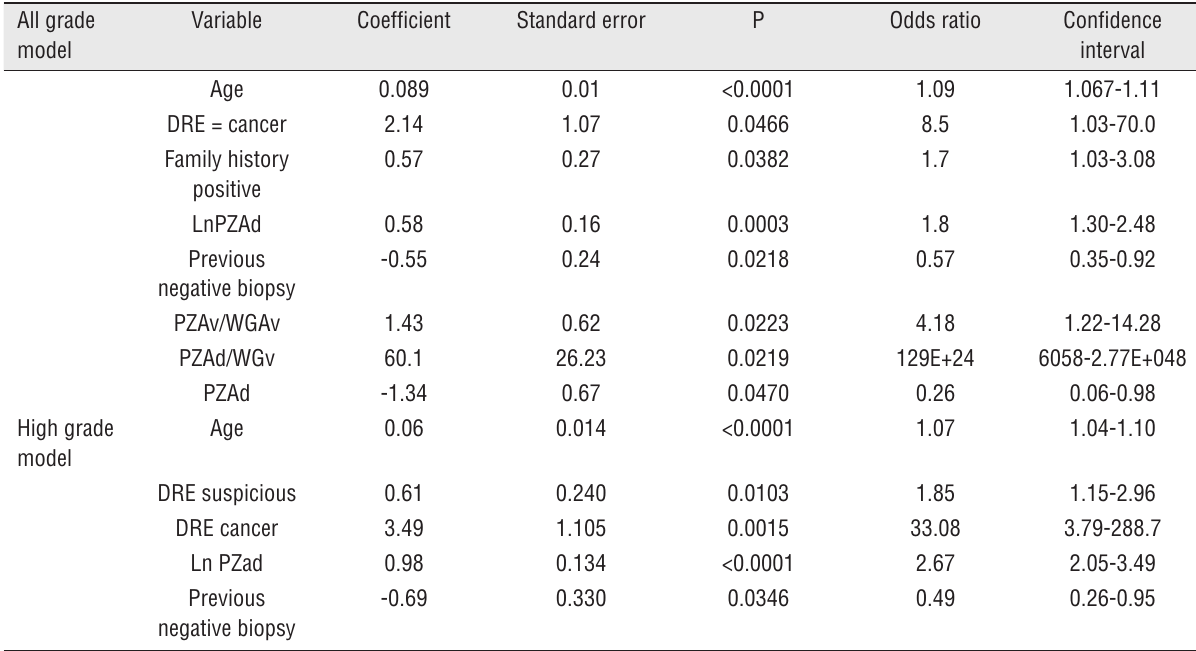
Table 2 - All grade and high grade models. All grade